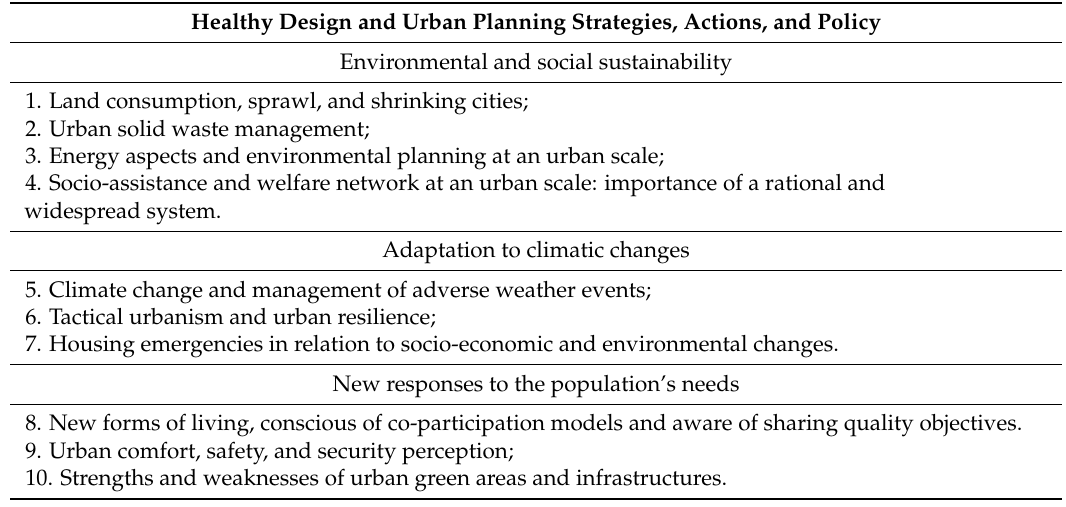
Table 2. Objectives and key points for healthy design and urban planning